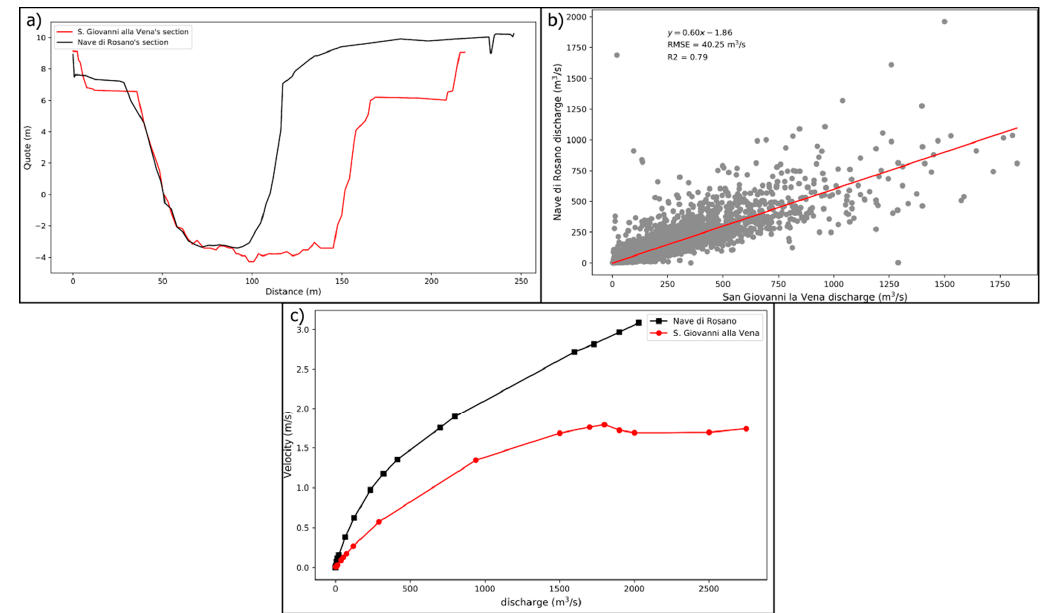
Figure 11. ( a ) River cross-section at S. Giovanni alla Vena gauge (red line) and Nave di Rosano (black line); ( b ) relation between discharges of the Arno River at S. Giovanni alla Vena and at Nave di Rosano; ( c ) relation between discharge and flow velocity resulting from the outflow scale at S. Giovanni alla Vena (red curve) and at Nave di Rosano (black line). The location of the two gauges is highlighted in Figure 1c.